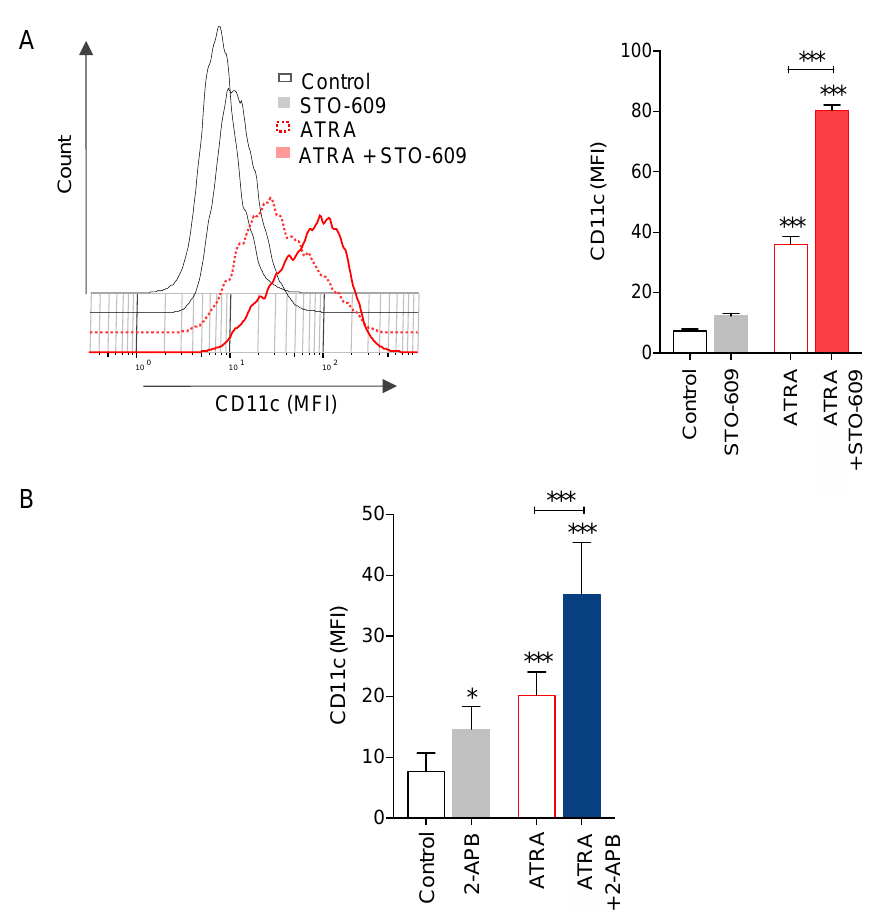
Figure 5. Pharmacological inhibition of SOC channels and CAMKK2 enhanced ATRA-induced cell death. ( A ) NB4 cells were pre-treated with 5 μg/mL STO609 and then treated with 1 μM ATRA for 72 h. Granulocytic differentiation was determined by cytofluorometric evaluation of CD11c expression. Left panel, representative flow cytometry histograms are shown; right panel, the median fluorescence intensity (MFI) of CD11c was scored for each sample. ( B ) NB4 cells were pre-treated with 44 μM 2APB and then treated with 1 μM ATRA for 72 h and granulocytic differentiation was determined. Results correspond to the means ± SD of three independent experiments realized in triplicate. p value* < 0.05, p value *** < 0.001.